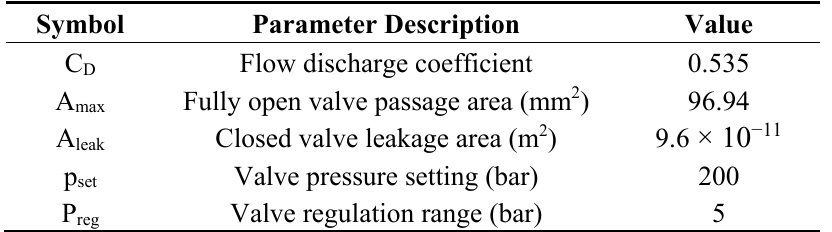
Table 8. Pressure relief valve main